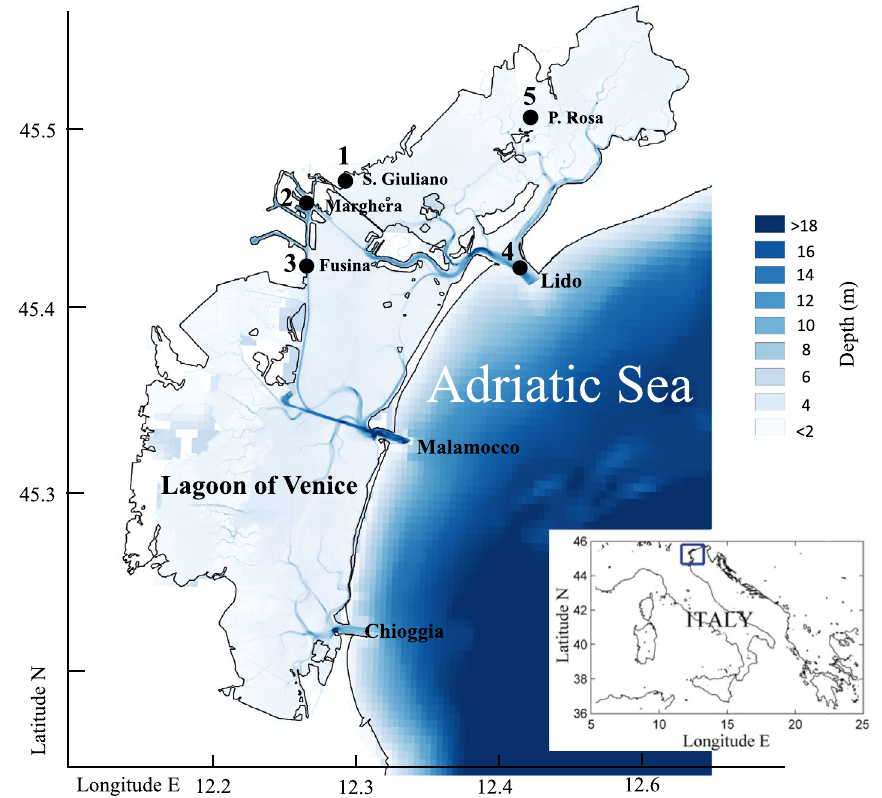
Figure 1. Study area (Lagoon of Venice, Italy) and location of sampling stations, modified from 36